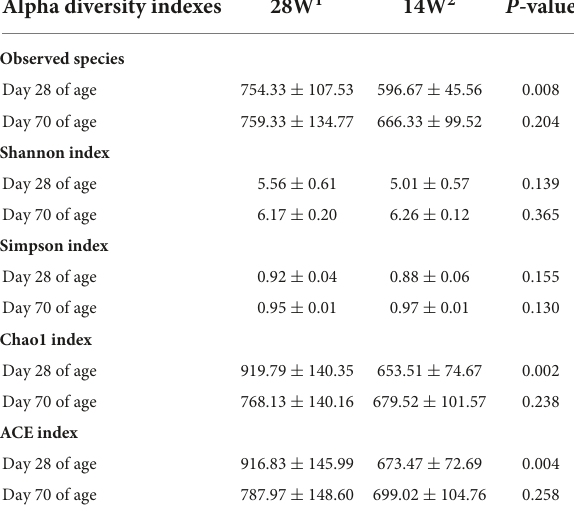
TABLE 4 Summary of next generation sequencing data and effects of ultra-early weaning on diversity and abundance indexes at each sampling time in post-weaning piglets.